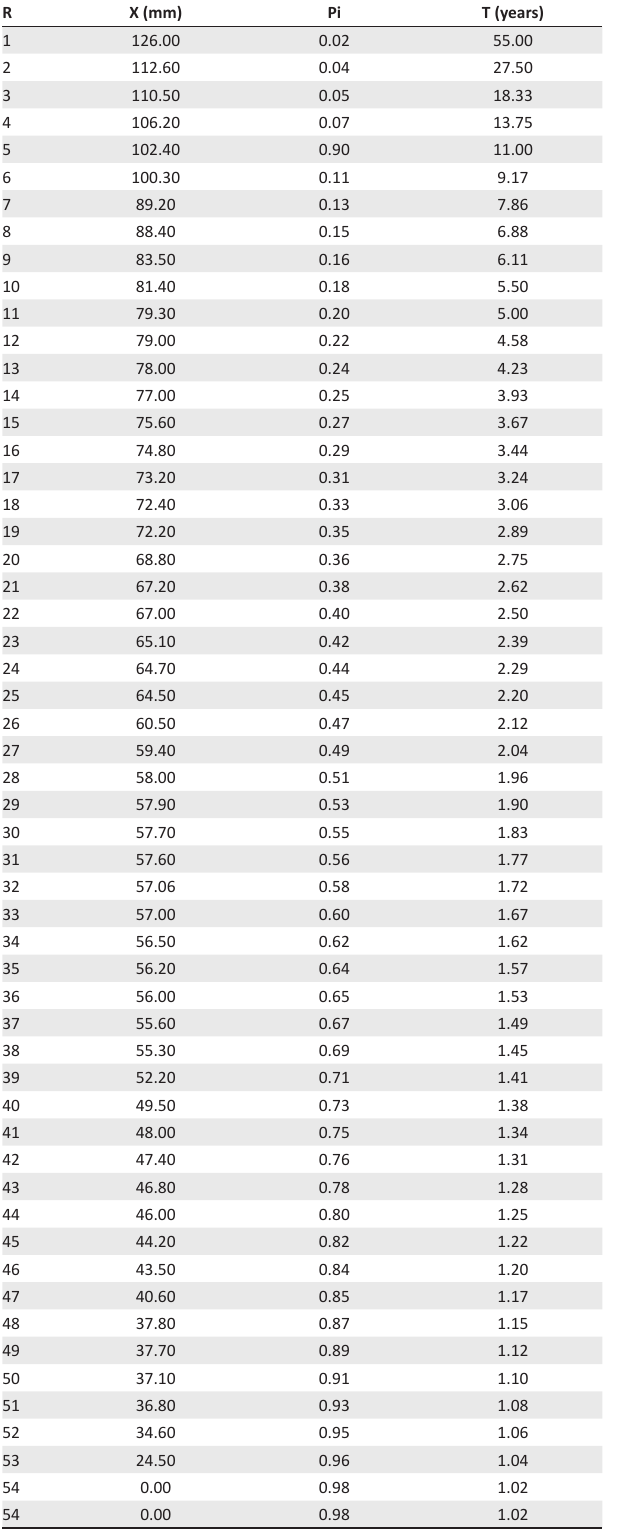
TABLE 3: Plotting positions and return periods. TABLE 4: Exceedance probability of flood disaster event (X ≥ 100 mm).